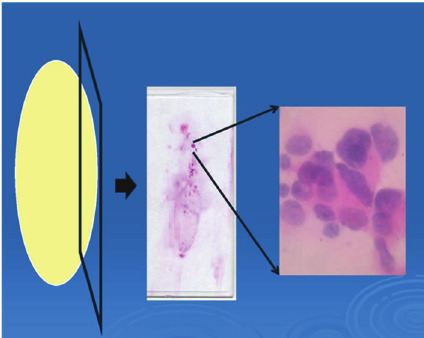
Figure 7: Method of obtaining touch imprints and/or smears. A slide is pressed against the surface of an excision specimen or the surface is scraped and smeared on a slide. The slide is then stained and examined for malignant cells. The microscopic image at the right shows enlarged irregular nuclei, consistent with carcinoma.